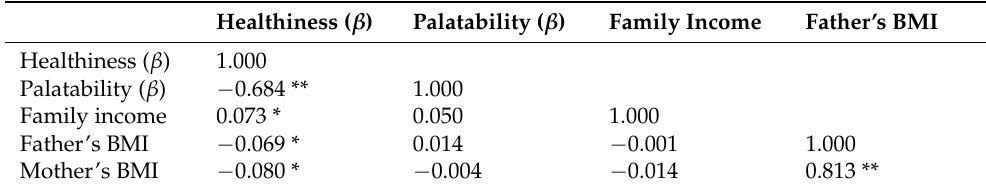
Table 4. The result of correlation analysis between family income and choice to eat. Healthiness ( β